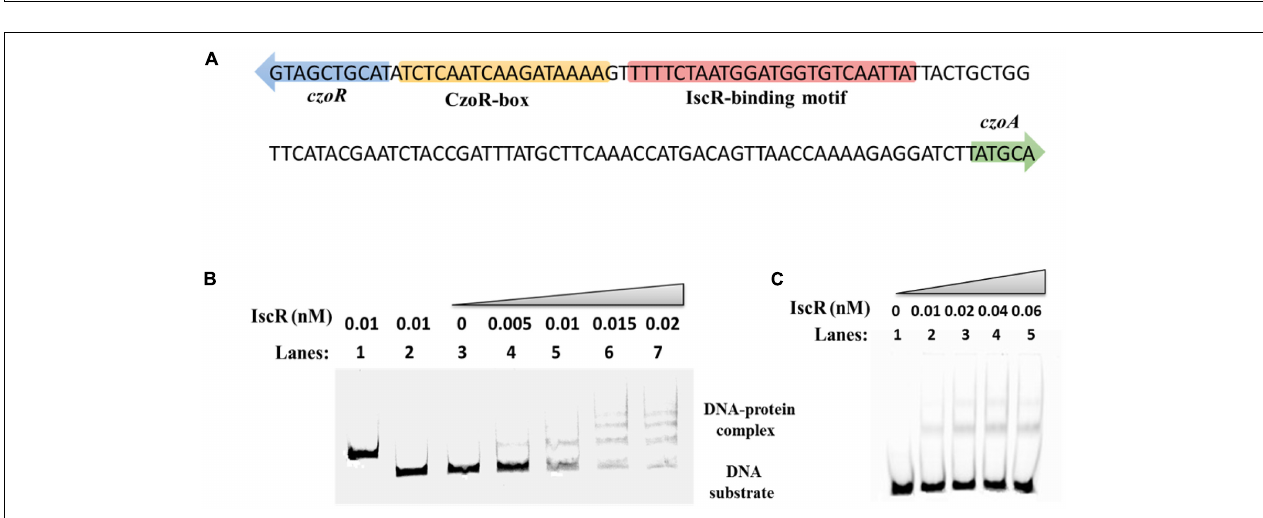
FIGURE 4 | EMSA and DNase I footprinting analyses of CzoR interaction with P czoA . (A) Results of EMSA analysis of CzoR interaction with PczoA . Bands 1–3 indicate negative controls: 1, DNA probe containing no CzoR-binding motif (non-specific DNA probe) in the presence of CzoR; 2, DNA probe containing P czoA (specific DNA probe) in the presence of heat-inactivated CzoR; 3, specific DNA probe only; Bands 4–8 represent 0.01, 0.02, 0.04, 0.06, and 0.08 nM of CzoR incubated with a specific DNA probe; Bands 9–11 represent the competition assay using 1.8 pmol of the FAM-label promoter region of czoA and 0.1 nM CzoR competed against 0, 3.6, and 8.0 pmol of unlabeled promoter region of czoA . (B) Footprinting assay. The concentrations (nanomolar) of CzoR are indicated in the left lanes; reactions in each lane contained 100 ng of the FAM-labeled P czoA region with or without CzoR protein. The gridlines denote the regions protected by CzoR. (C) Sequence of the CzoR motif predicted by footprinting analysis. The CzoR box (yellow bars) and the P czoA sites (–35 and –10) are indicated. (D) EMSA for the DNA-binding activity of CzoR and P czoA without the CzoR box.